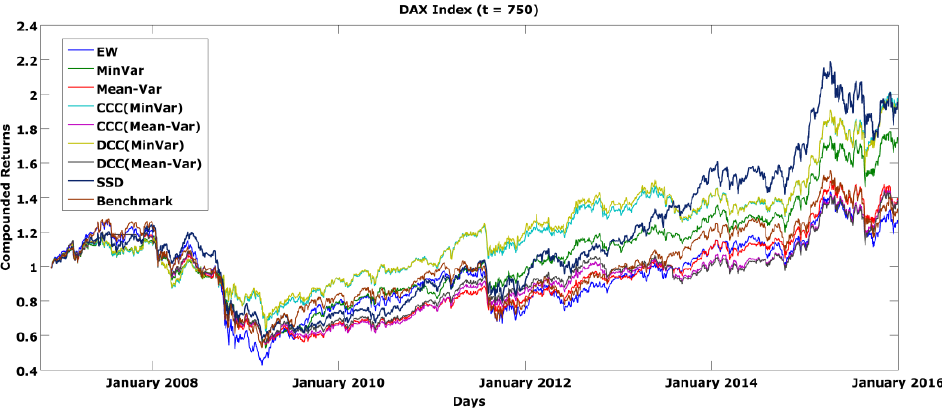
Figure 5. Compounded (on daily basis) returns of portfolios consisting of DAX stocks, t = 750.